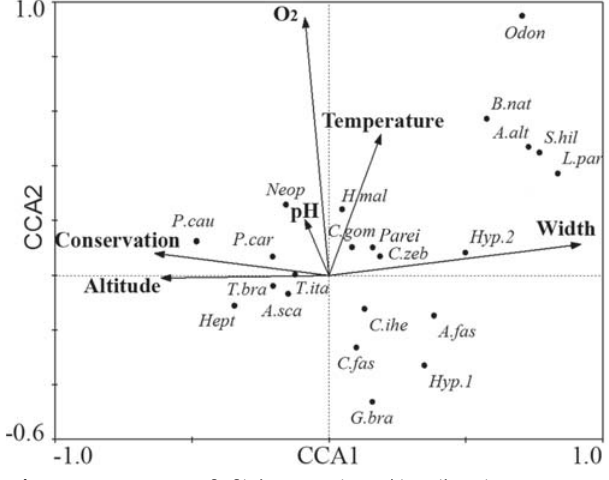
Fig. 5. Pattern of fish species distribution among environmental variables, based on canonical